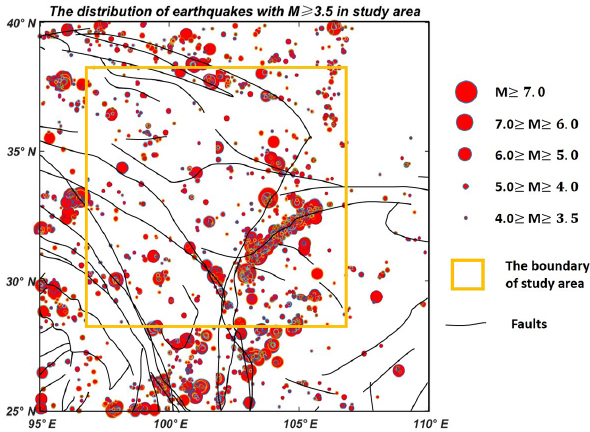
Figure 3. The spatial distribution of earthquakes in the study area. The orange rectangle represents the study area (27 to 37 ◦ N, 97 to 107 ◦ E). Earthquakes beyond the parameters of the study area are shown because earthquakes close to the study area may also cause TIR anomalies within the study